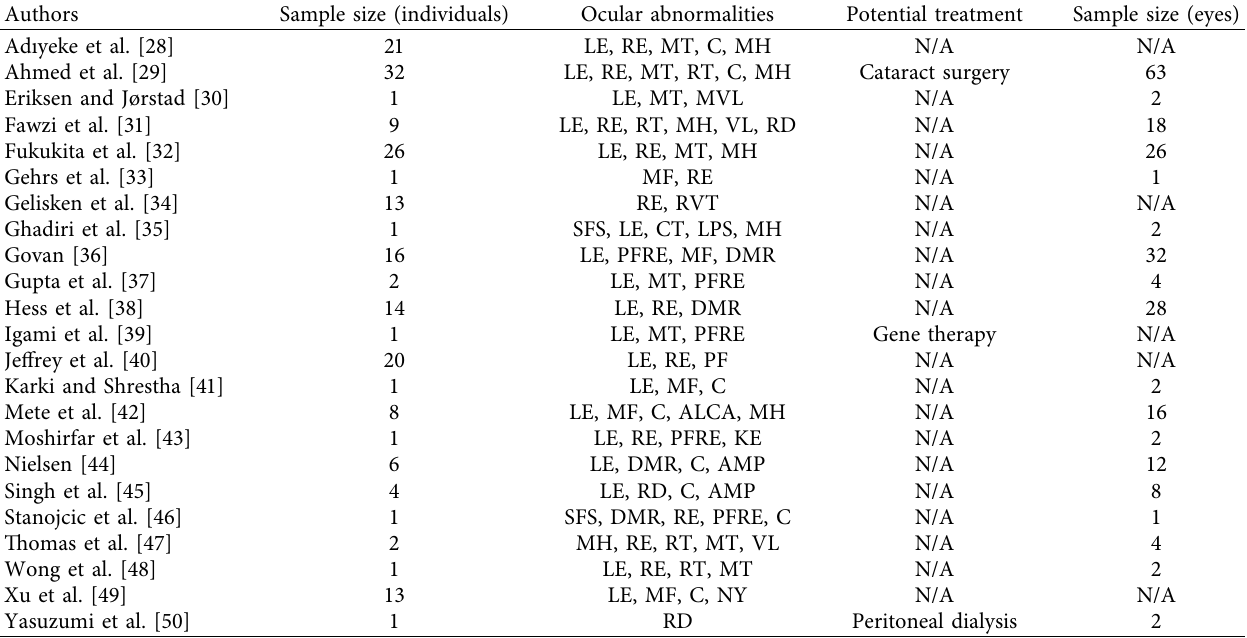
Table 1: Summary of ocular abnormalities in AS patients from 1977 to